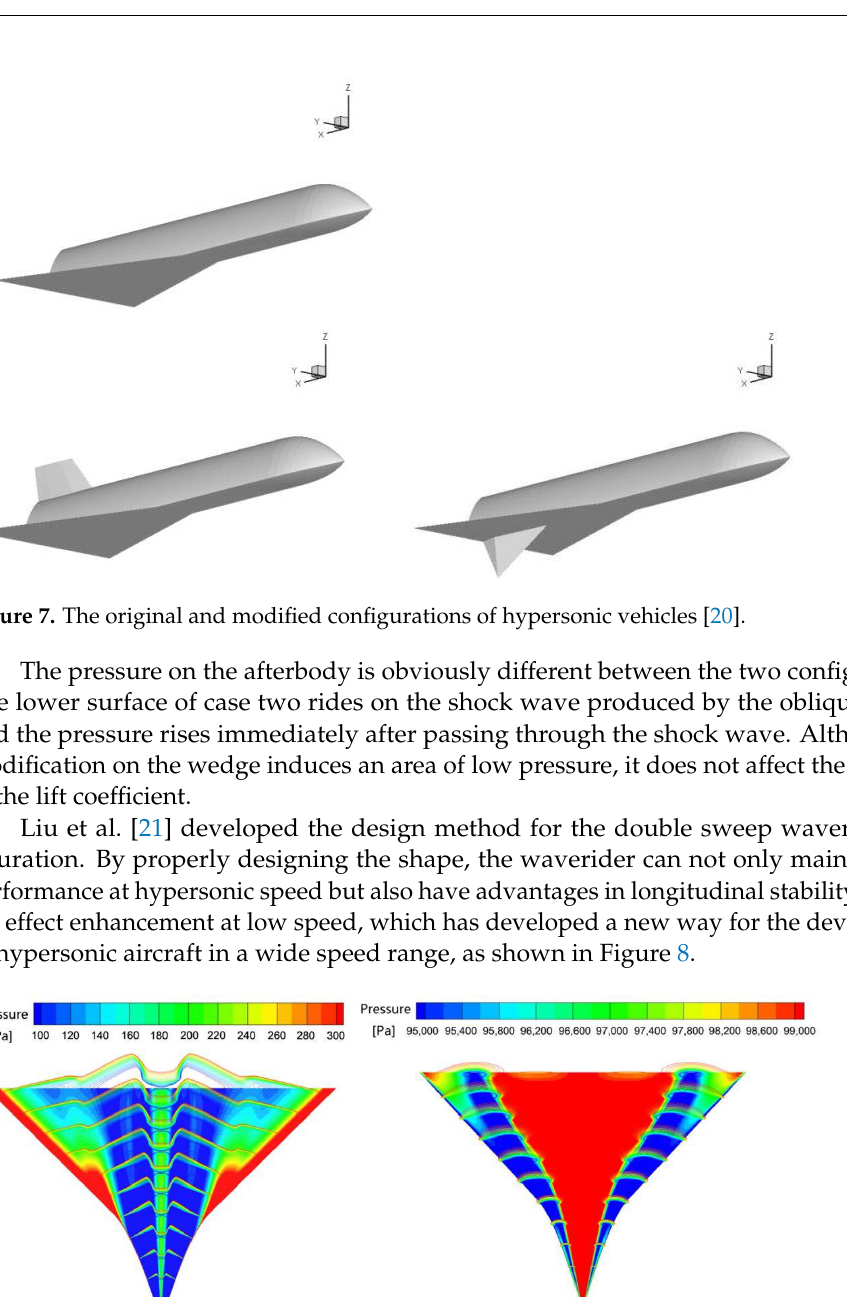
Figure 9. Trihedral figure of proposed twin-body/biplane-wing configuration [22].